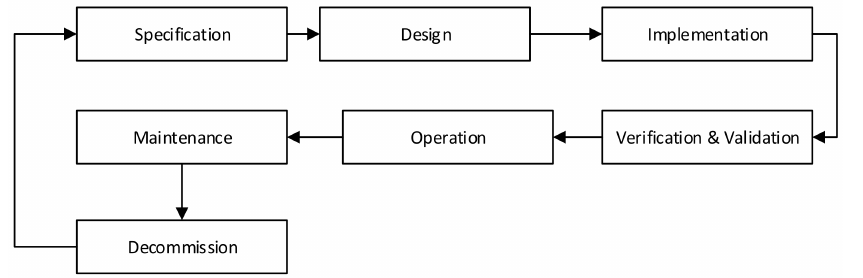
Figure 2. Automation solution (CPS) lifecycle as per ISA99 [14].